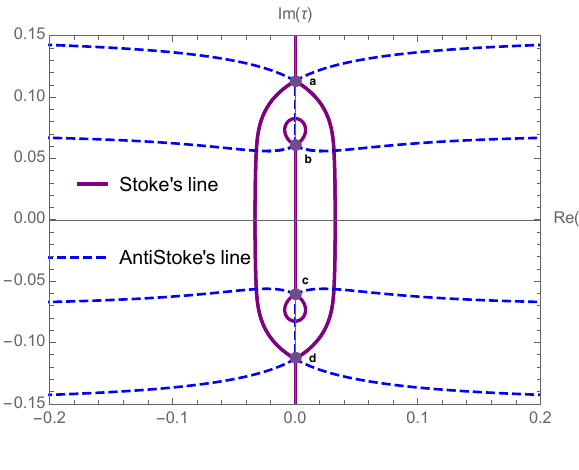
Figure 11 . Stoke’s and anti-Stoke’s curves.